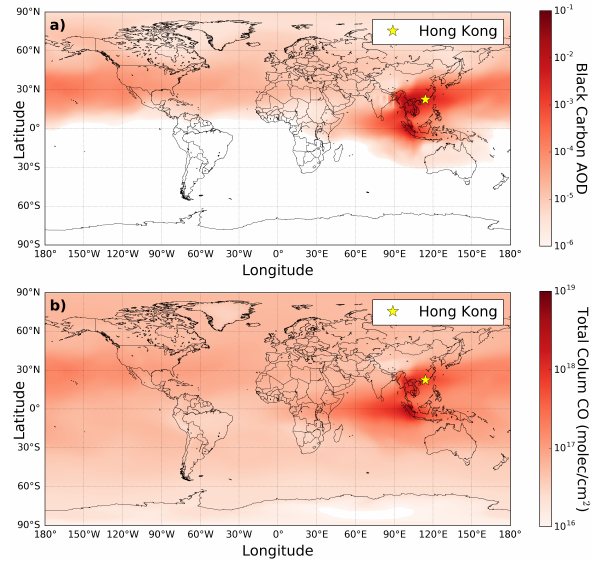
Figure 8. MODIS cumulative fire radiative power over Asia in (a) March and (b) April 2014 overlaid with the cluster analysis of the 48 hours backward trajectories. The percentage of occurrence of each cluster is indicated.